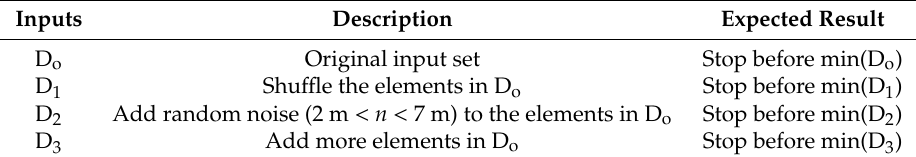
Table 3. Test inputs for stopping regardless of obstacle order.